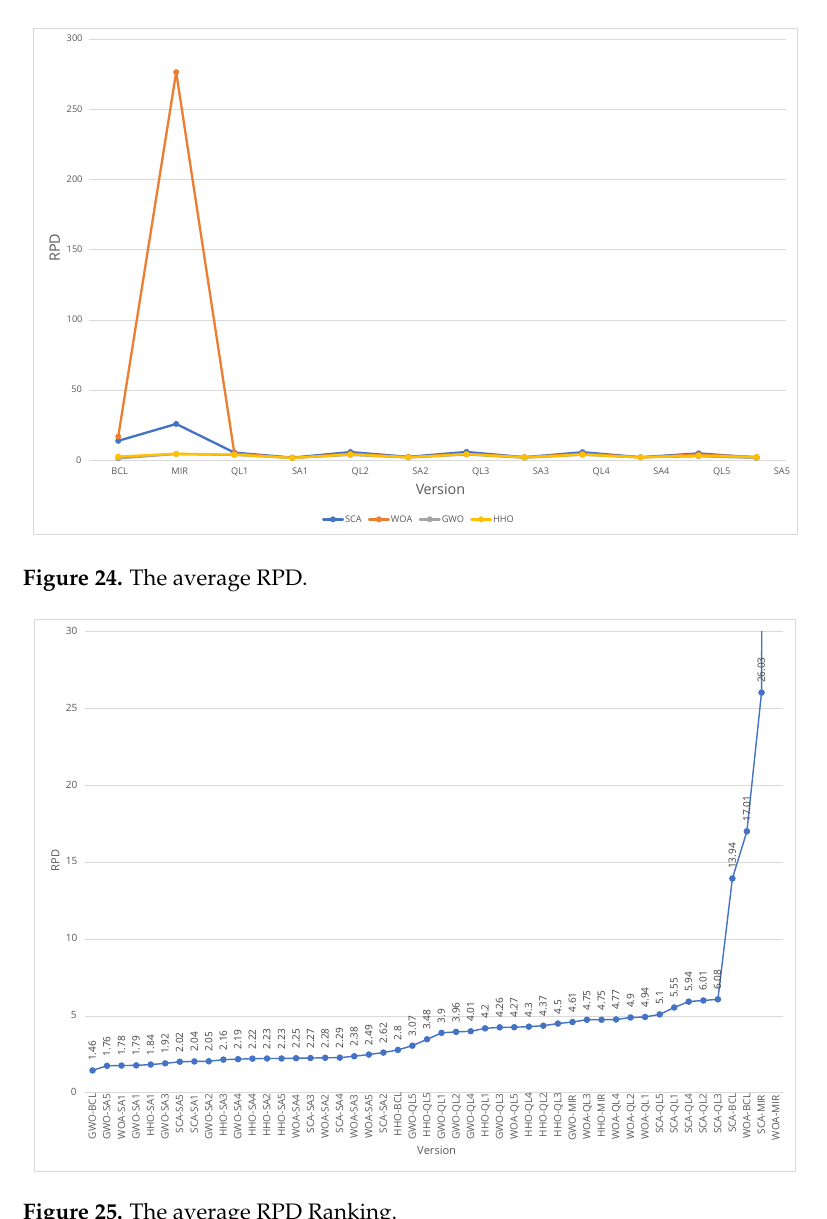
Figure 25. The average RPD